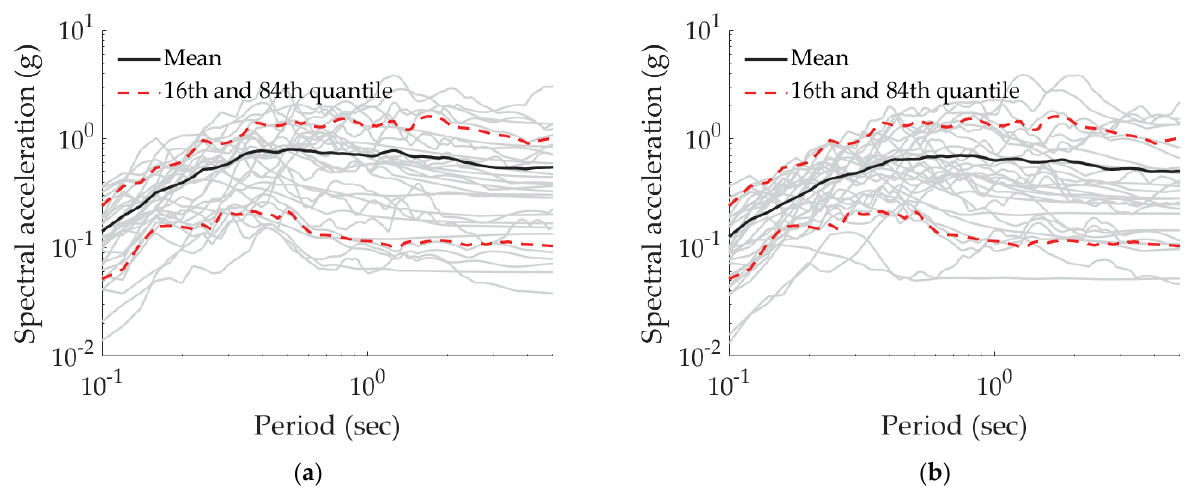
Figure 12. Response spectra of the bi-directional components of the selected ground motion records: ( a ) horizontal component in X-direction; ( b ) horizontal component in Y-direction.